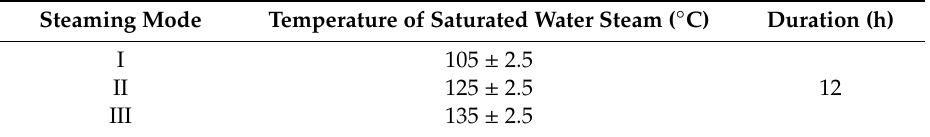
Table 1. The parameters of hydrothermal treatment of birch